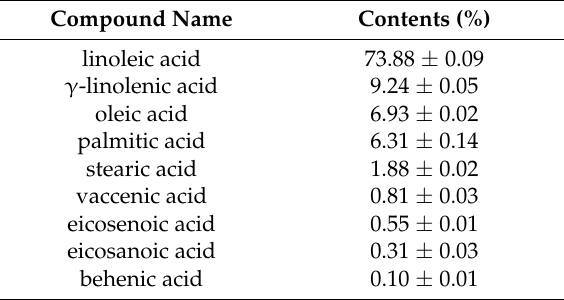
Table 1. Fatty acid composition of evening primrose oil (EPO) ( Oenothera biennis L.)